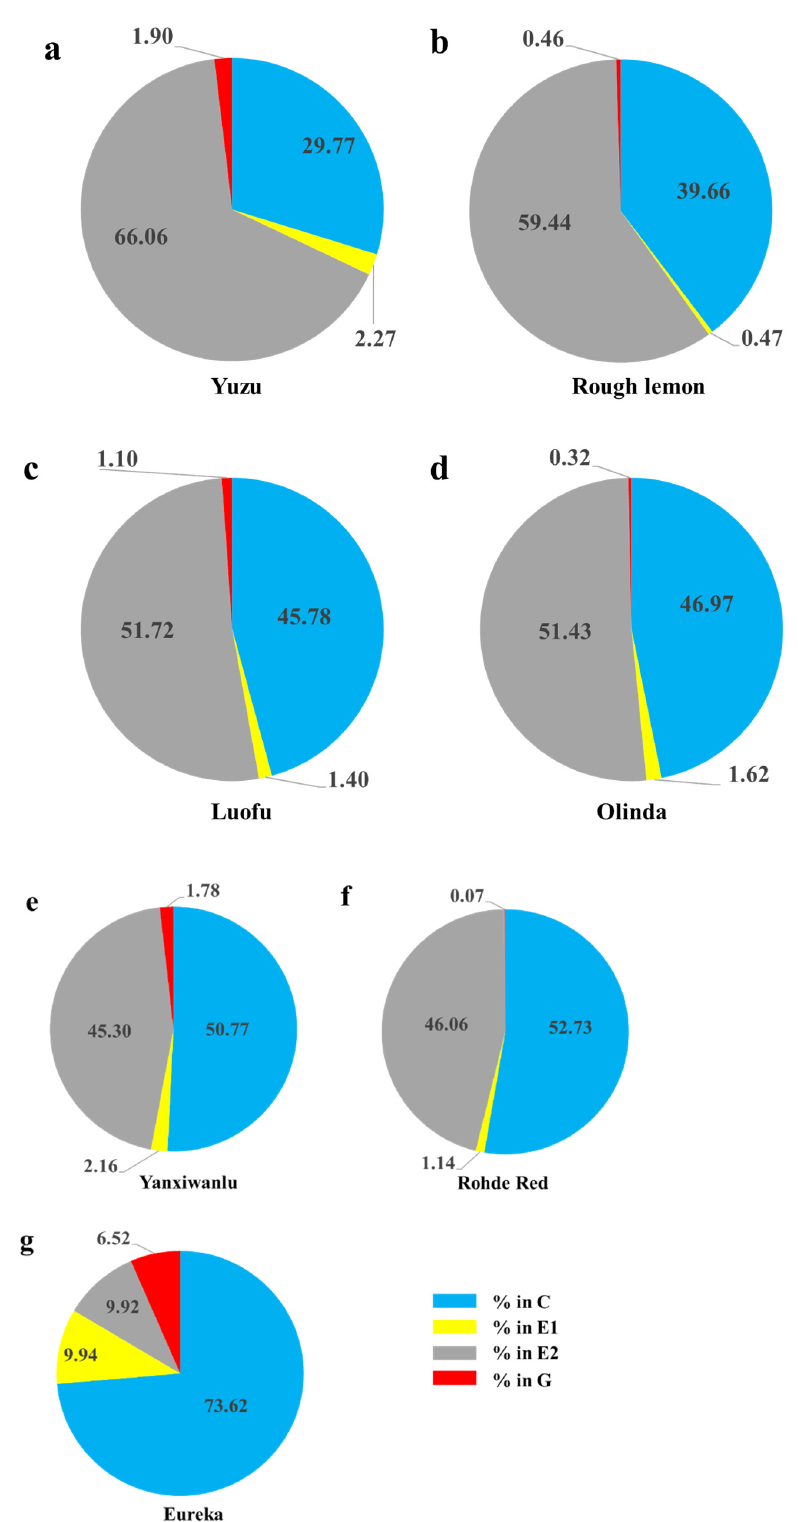
Figure 1. Total percentage of time per individual Toxoptera citricida spent ingesting in the pathway, xylem and phloem phases (the sizes of each pie slice) on seven host plants: pathway waveforms (C), phloem salivation (E1), phloem ingestion (E2), and xylem activities (G). ( a ) Yuzu, n = 25; ( b ) Rough Lemon, n = 21; ( c ) Luofu, n = 15; ( d ) Olinda, n = 24; ( e ) Yanxiwanlu, n = 25; ( f ) Rohde Red, n = 25; (g) Eureka, n = 15.